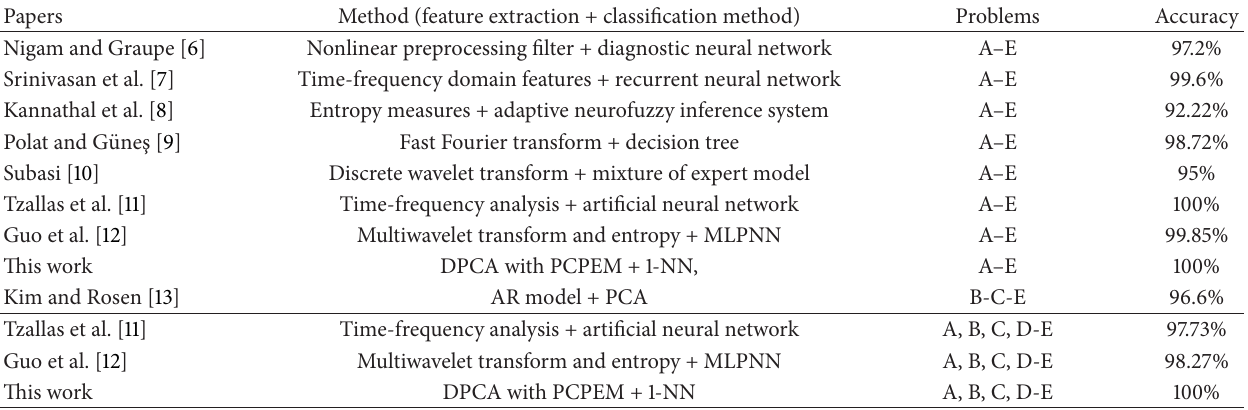
Table 3: A comparison of classification accuracy obtained by various methods for epileptic seizure detection problem using EEGs dataset from the University of Bonn.